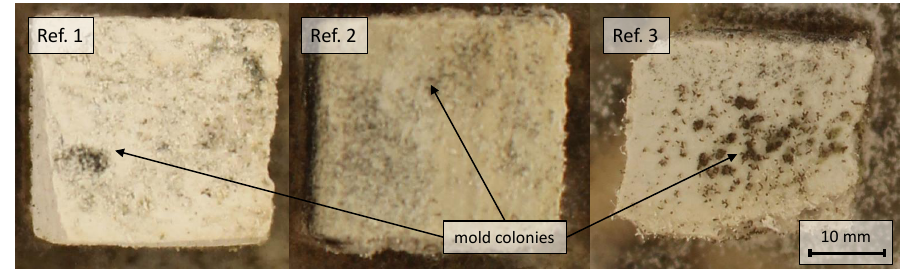
Figure 3. Surface of reference samples after 41 days of exposure to molds and bacteria.